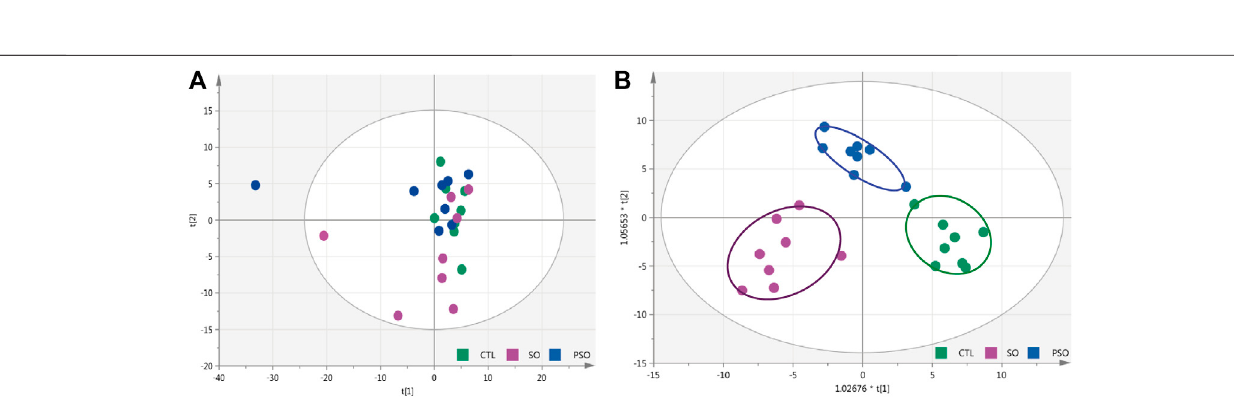
Frontiers in Pharmacology |